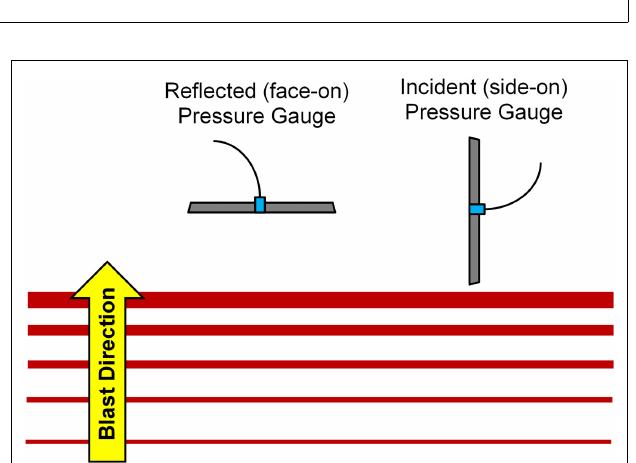
FIGURE 2 | Pressure transducer orientation for incident and reflected pressure measurements (Bass et al., 2012) .